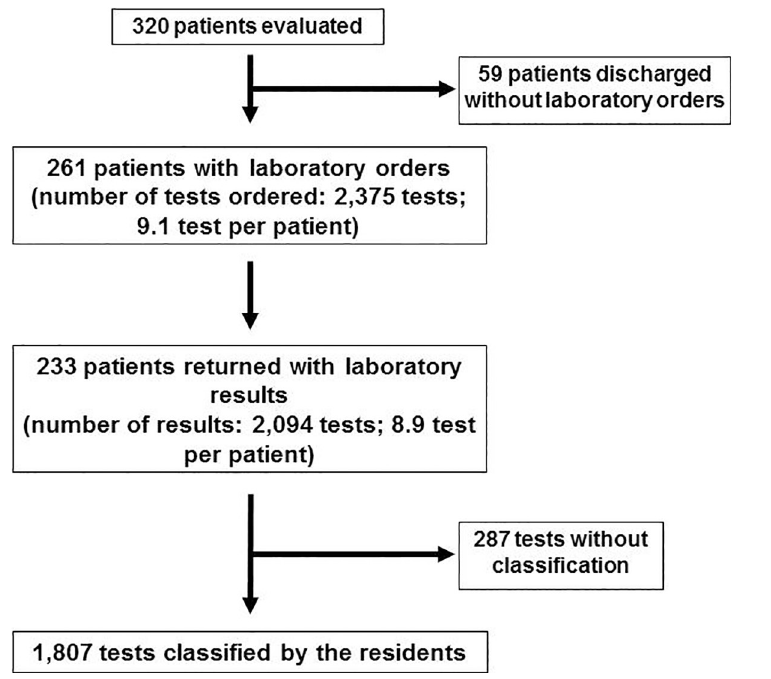
Fig 1. Flowchart of patient evaluation and